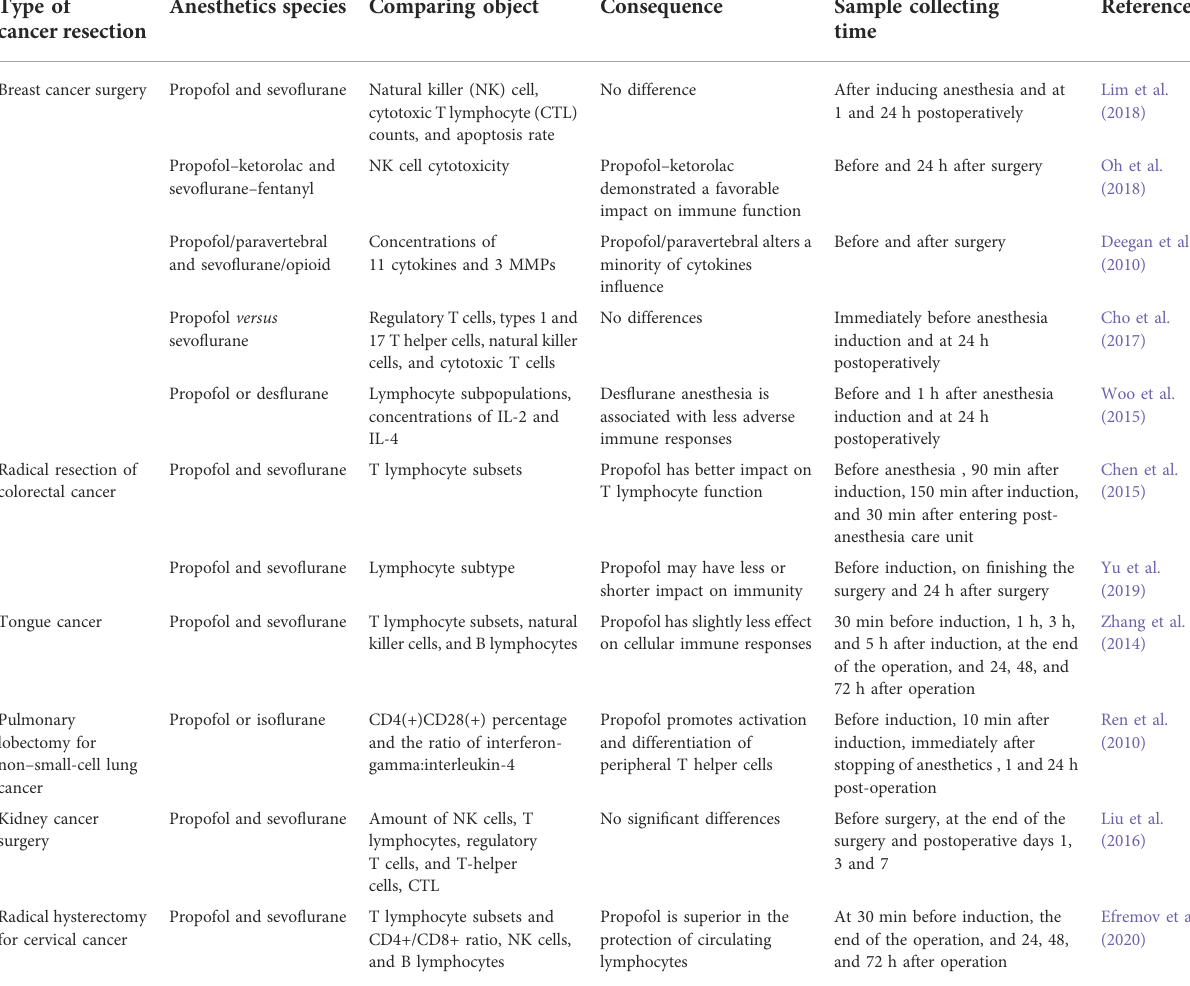
TABLE 2 Comparison of immunomodulation between propofol and volatile anesthetics in cancer resection. Type of Anesthetics species Comparing cancer resection